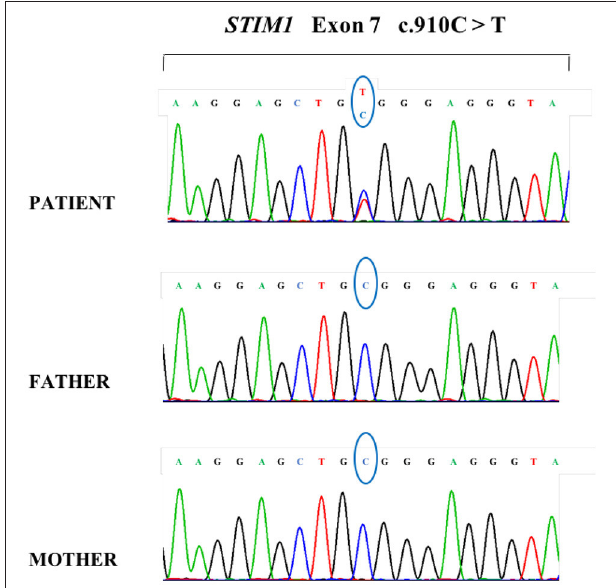
FIGURE 4 | DNA sequencing analysis of the patient and her parents demonstrating a de novo heterozygous transition in the patient with the common c.910C > T mutation in STIM1